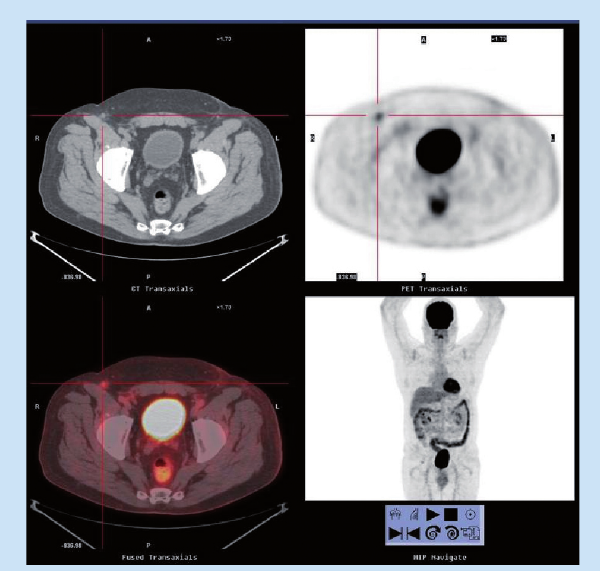
Fig. 1. Transaxial CT, PET and fusion images demonstrating a metabolically active sub-centimetre right inguinal lymph node.